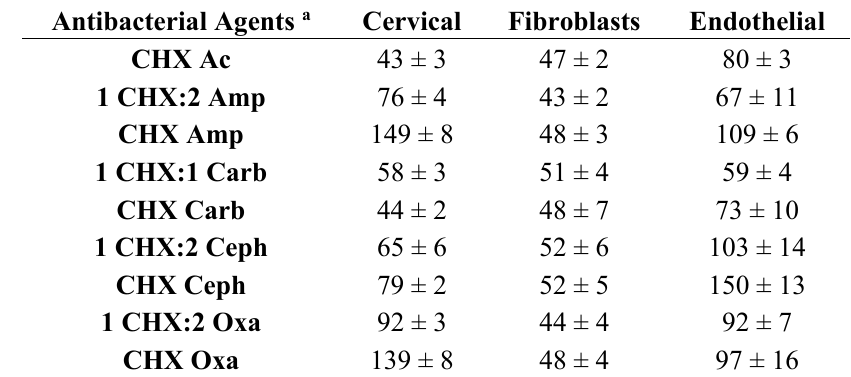
Table 6. Acute cytotoxicity (LD 50 , µM) of β-lactam-based chlorhexidine GUMBOS. Antibacterial Agents a